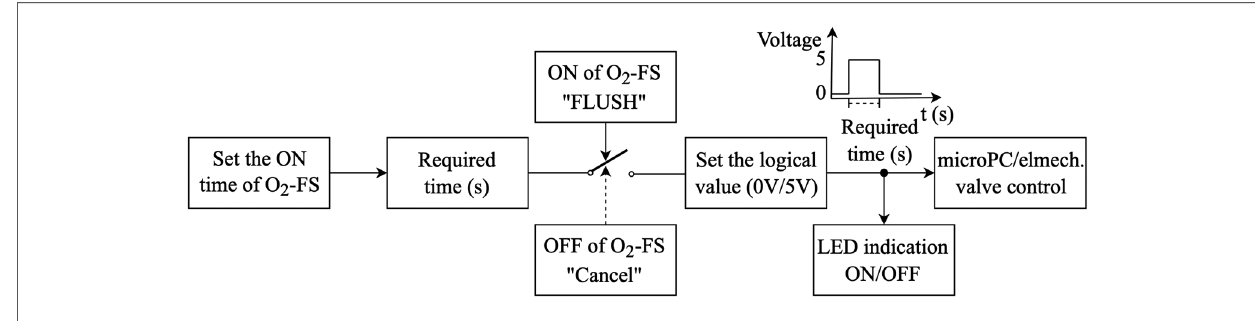
FIGURE 4 The schematic arrangement of the O 2 -FS operation.